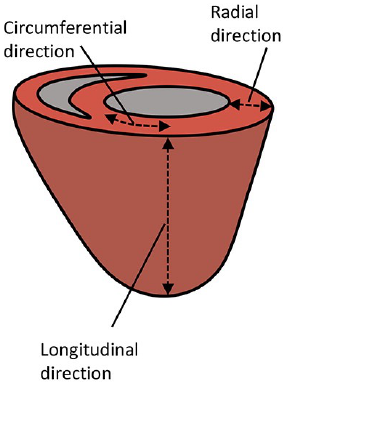
Figure 1. ( a ) Macro-scale diagram of the reference directions most commonly used in cardiac imaging, adapted from Wilson et al. (2022) [4]. ( b ) Annotated SAX CMR slice from the Automated Cardiac Diagnosis Challenge (ACDC) public dataset, MICCAI 2017 [5]. The expert annotations include segmentation masks for the LV blood pool, myocardium, and RV (respectively indicated in red, green, and blue). This particular subject was diagnosed with Dilated Cardiomyopathy (DCM).